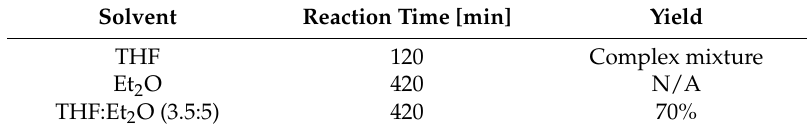
Table 2. Solvents used for the homodimerization of 3-dialkylphosphonocoumarins 1a – b (Method A). Solvent